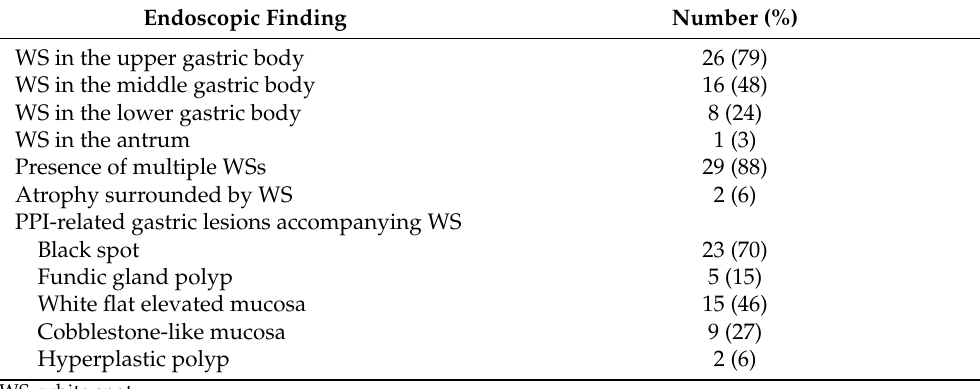
Table 5. Endoscopic findings in the 33 patients with white spot.